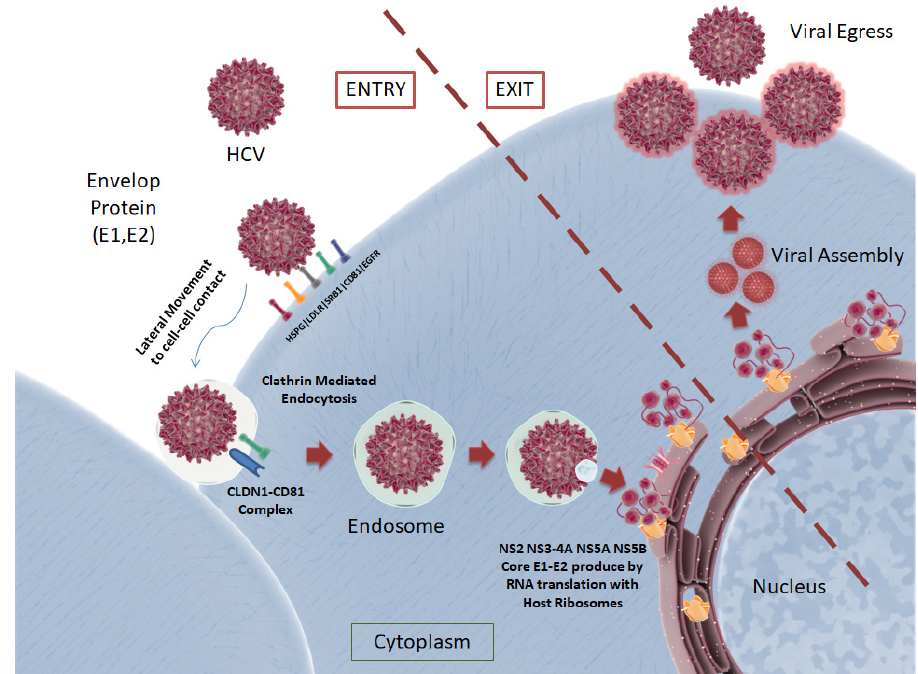
Figure 5. The HCV lifecycle depicted: Two surface proteins, E1 and E2, present on the viral envelope play a role in the attachment to host cell receptors LDLR, HSPG, SRB1, CD81 and EGFR. RNA replication with host ribosomes takes place, followed by viral particle assembly and egress. CC BY 4.0 license